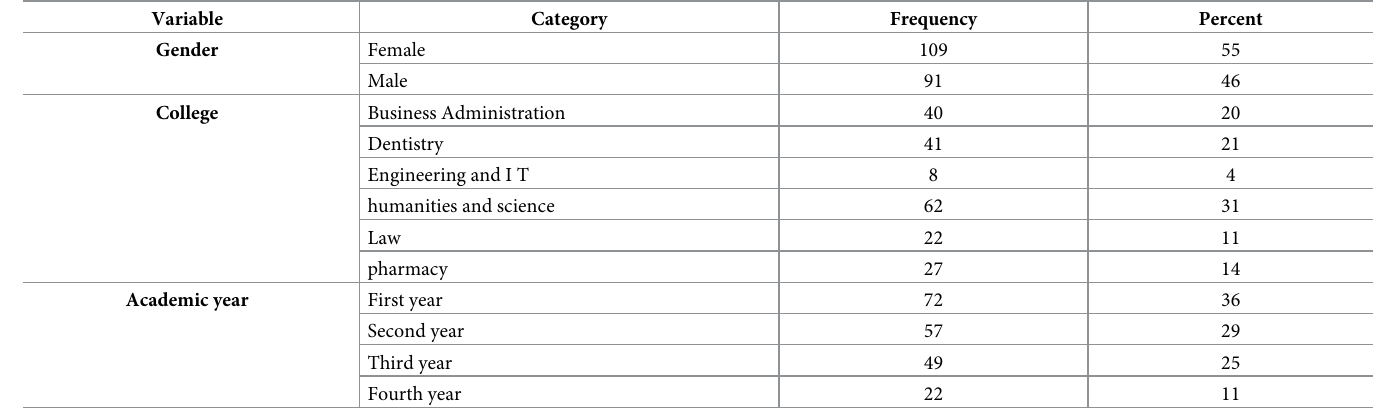
Table 1. Demographic characteristics.